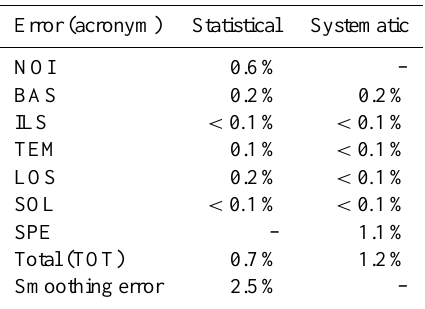
Table 5. Same as Table 4 but for δ D and with smoothing error as well as error due to cross-dependence on